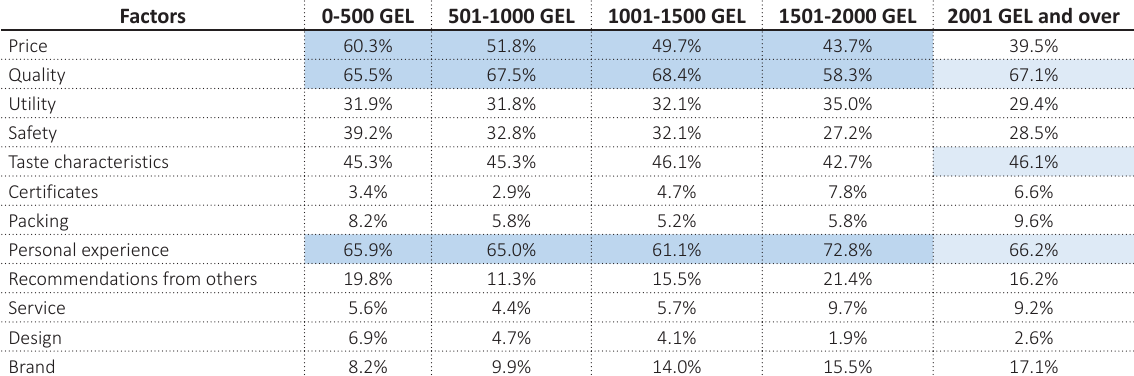
Table 6. Results to the question: Which of the following factors determines your choice when purchasing agri-food products? Choose maximum three answers. Seen in terms of revenue Source: Constructed by the authors based on the data of the survey.